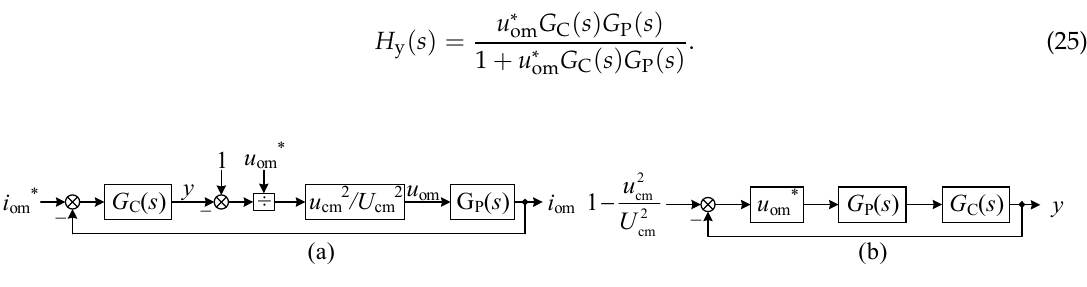
Figure 3. Signal flow graphs of the proposed feedback control strategy: ( a ) the large-signal control loop; ( b ) the small-signal control loop.